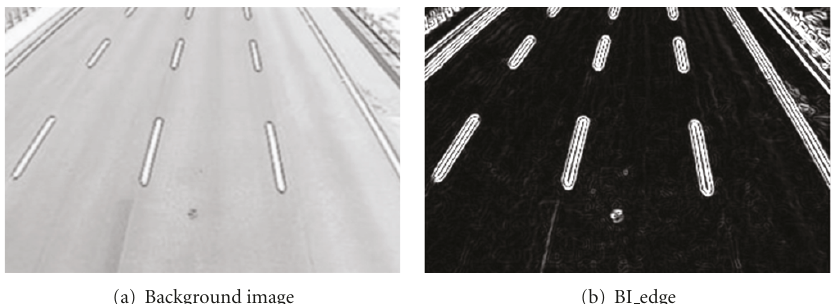
Figure 3: Sobel edge extraction from background images.